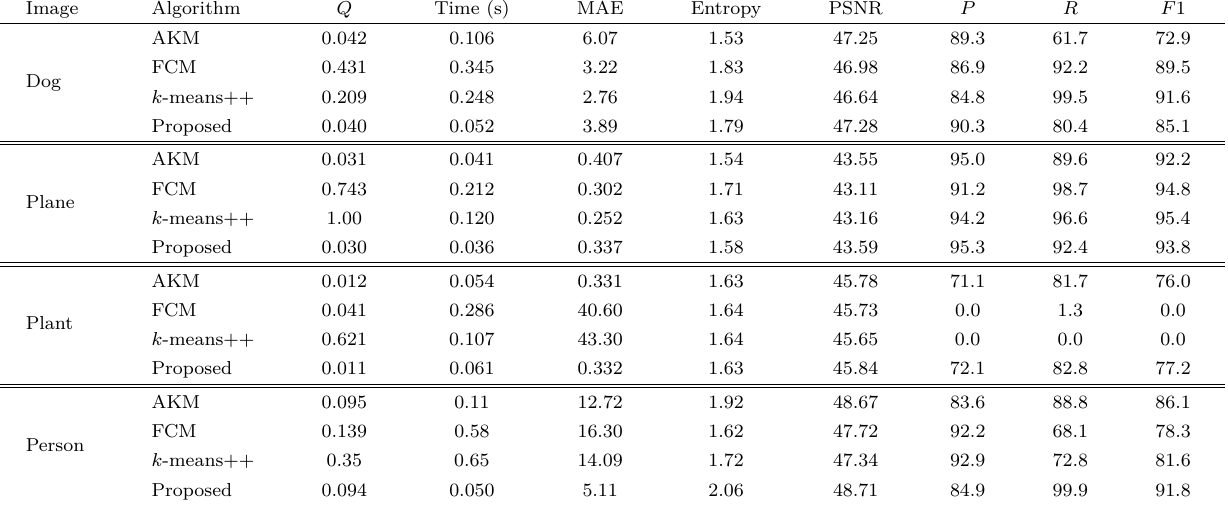
Table 8 Comparison of proposed method with clustering algorithms in terms of Q , computation time, MAE, entropy, PSNR, precision ( P ), recall ( R ), and F -score ( F 1) using VOC2012 dataset Image